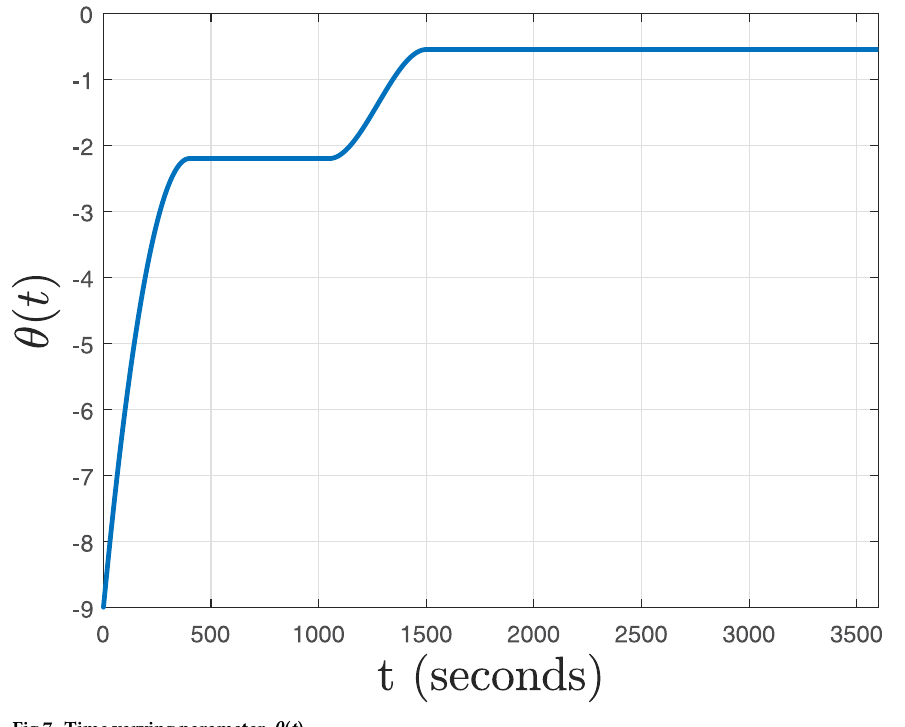
Fig 7. Time varying parameter, θ ( t ).